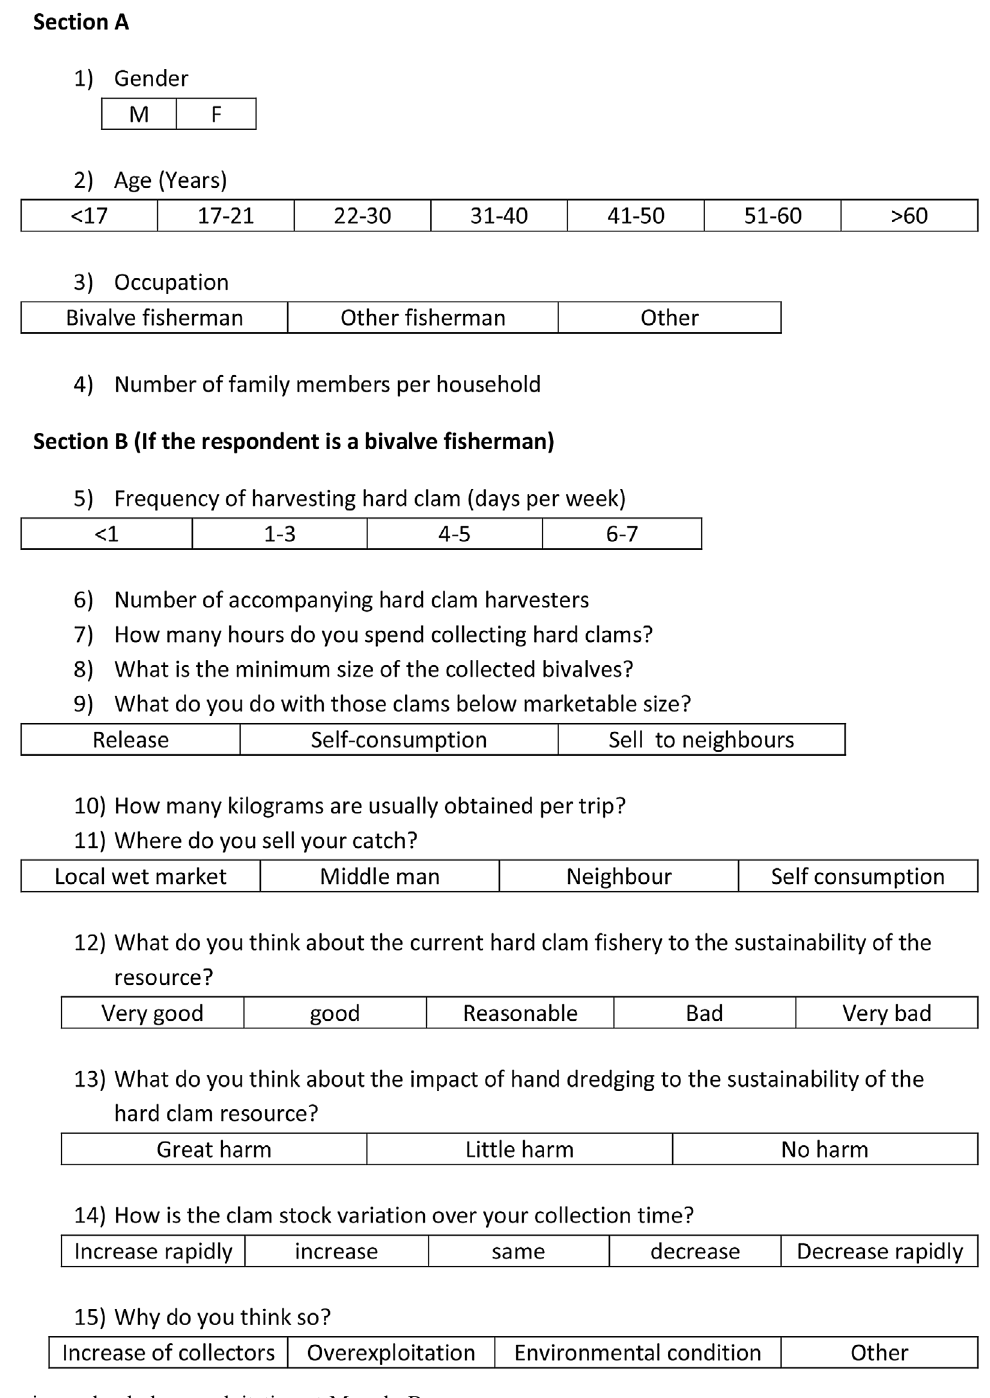
Fig. 3. Questionnaire on hard clam exploitation at Marudu